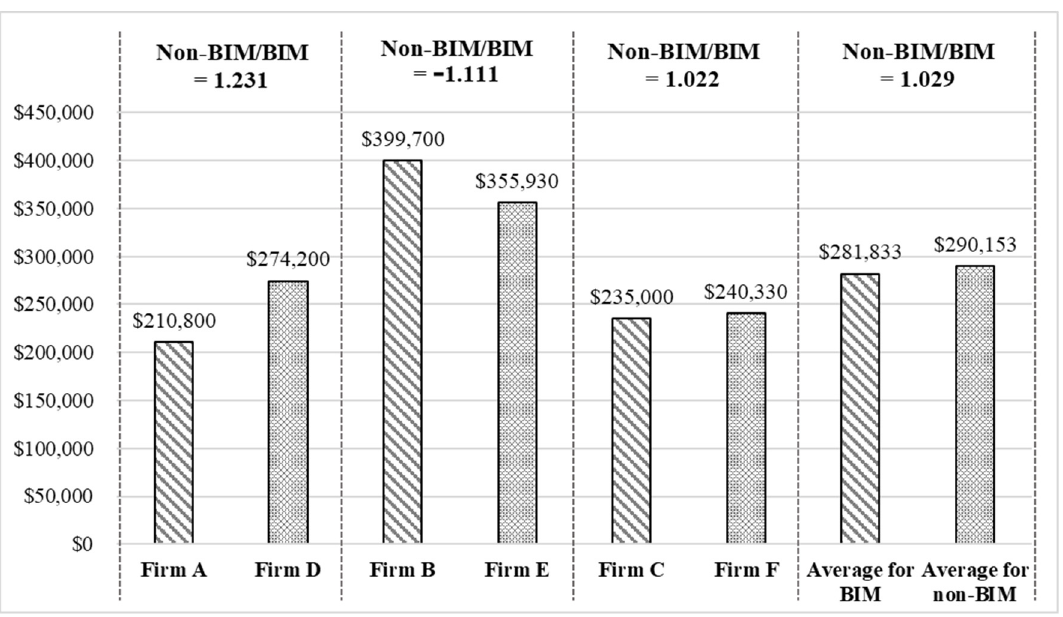
Figure 1. Productivity differences between BIM and non-BIM projects.